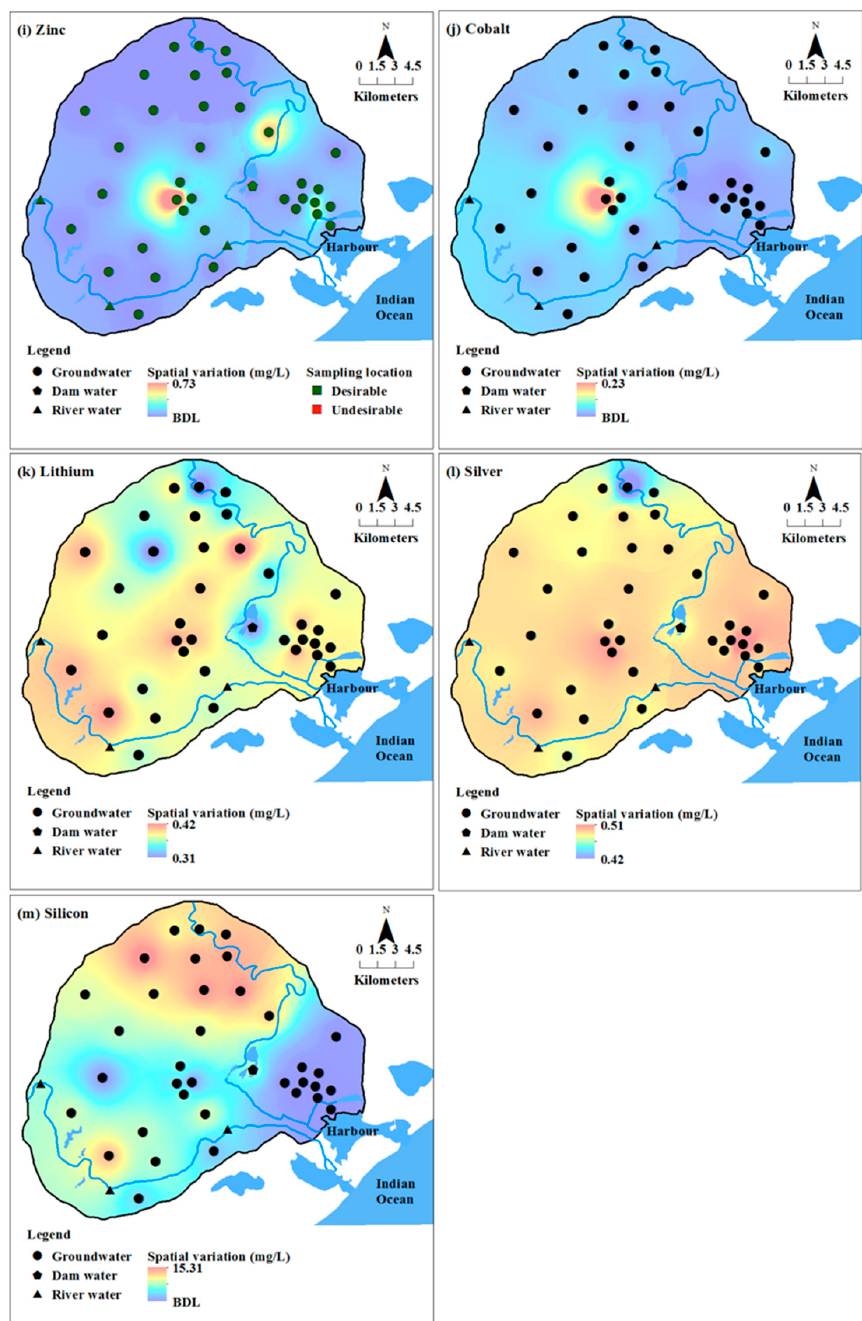
Figure 3. Spatial variation in heavy metal concentration in groundwater, ( a ) aluminium, ( b ) boron, ( c ) copper, ( d ) cadmium, ( e ) iron, ( f ) lead, ( g ) manganese, ( h ) nickel, ( i ) zinc, ( j ) cobalt, ( k ) lithium, ( l ) silver, and ( m ) silicon